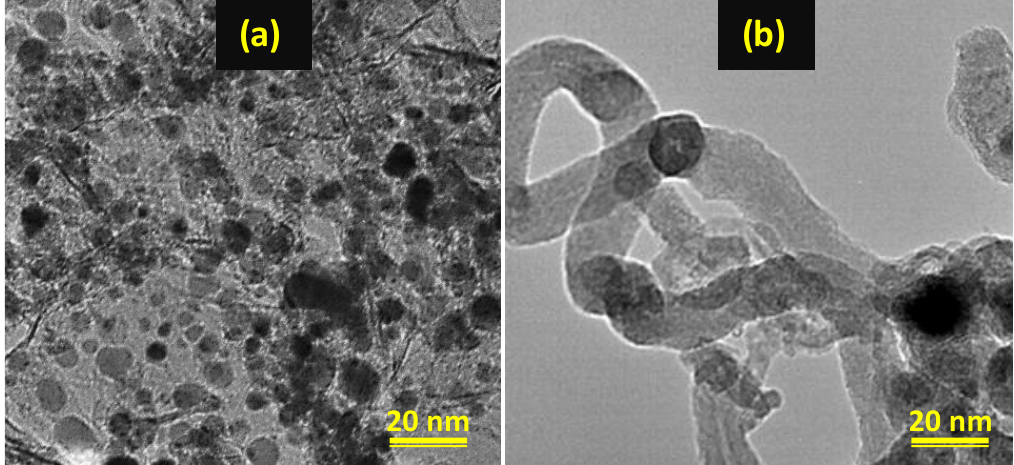
Figure 13 . TEM images of the Co-Fe/C catalyst ( a ) freshly synthesized by plasma, and ( b ) after pre-treatment in CO, indicating formation of carbon nanofilaments (CNFs).